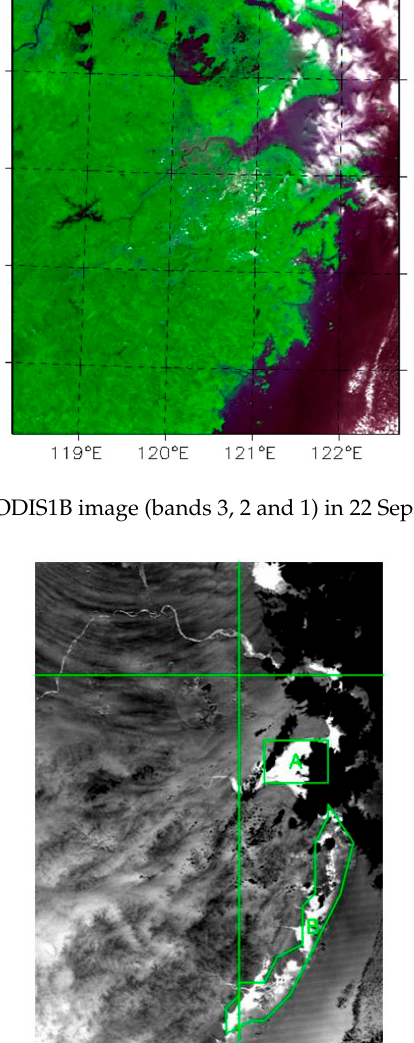
Figure 4. Water vapor content retrieved by NN. Figure 5. The difference between Figures 3 and 4.